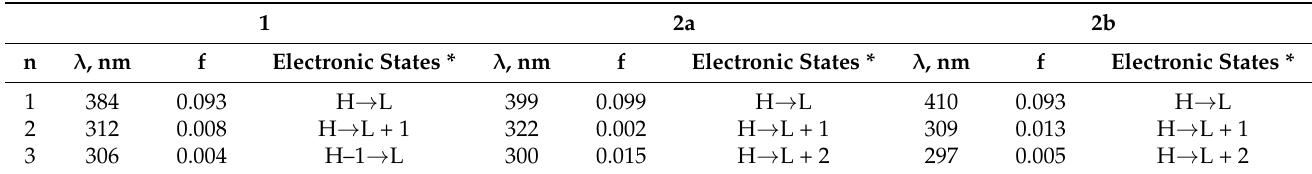
Table 2. Calculated characteristics for vertical S 0 –S n (n = 1–3) transitions for compounds 1 – 2